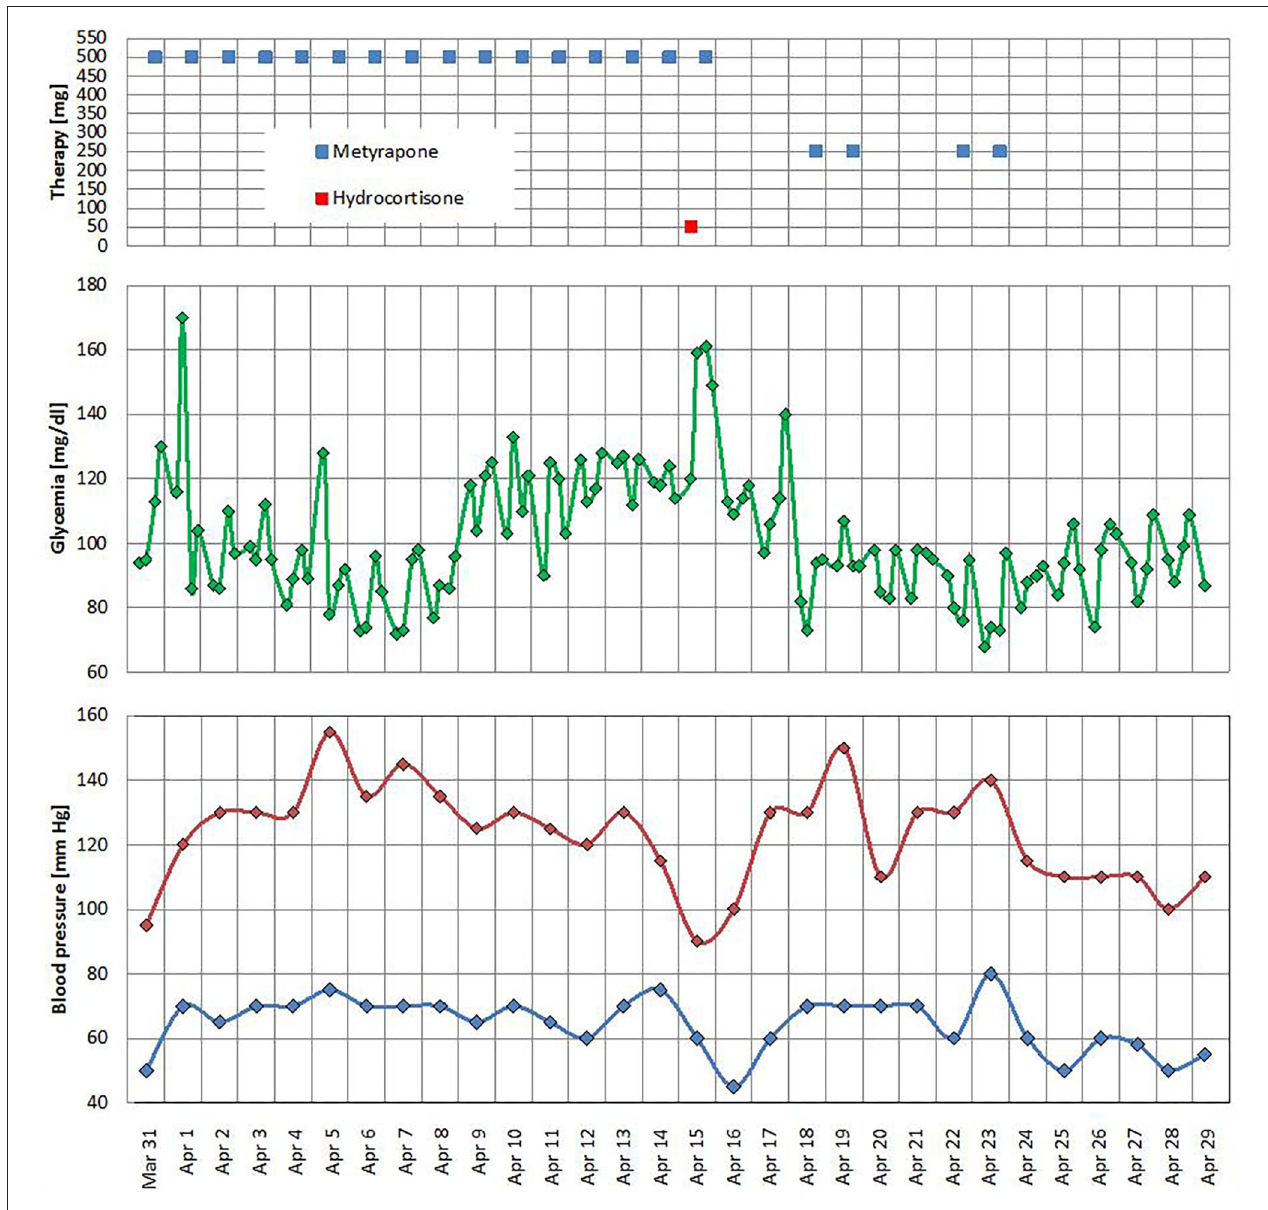
FIGURE 1 | Metyrapone and hydrocortisone treatments, glucose level, and office blood pressure